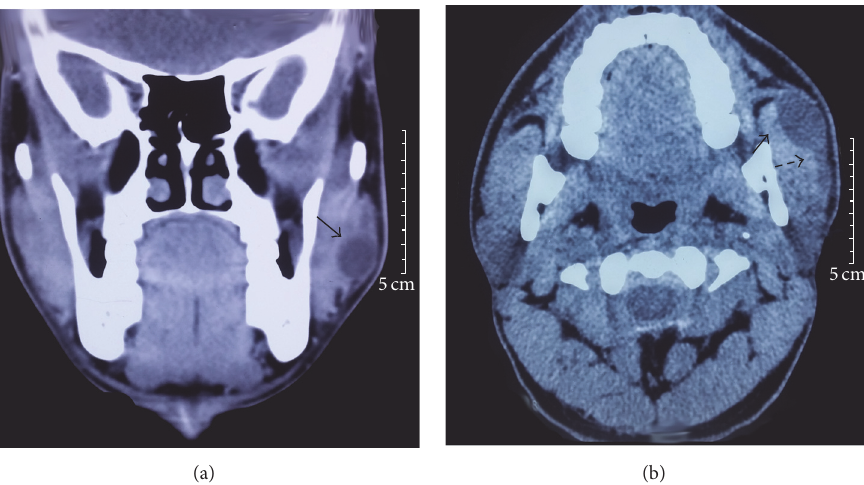
Figure 1: Coronal (a) and axial (b) cuts of computed tomography scan showing a small 2.2 cm × 1.5cm, well defined, hypodense cystic lesion superficial to the anterolateral aspect of the left masseter muscle indenting its surface (solid arrow), communicating with a tubular hypodense structure (dashed arrow) communicating with the parotid gland, suggestive of a dilated Stensen’s duct with a sialocele formation.